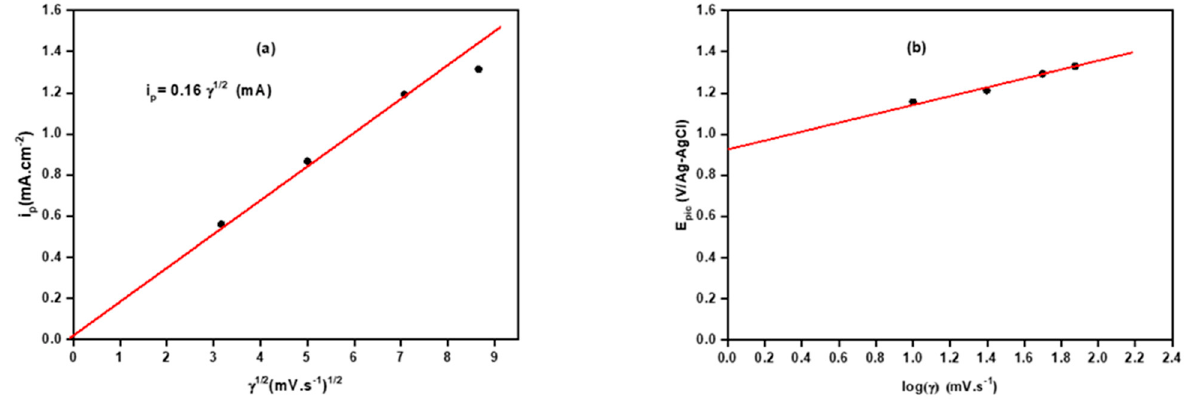
Figure 8. Peak current variation as a square root function of the scanning speed ( a ) and peak potential variation with the scanning speed logarithm ( b ). Table 2. Characteristics of voltamperograms obtained at the different scanning speeds.